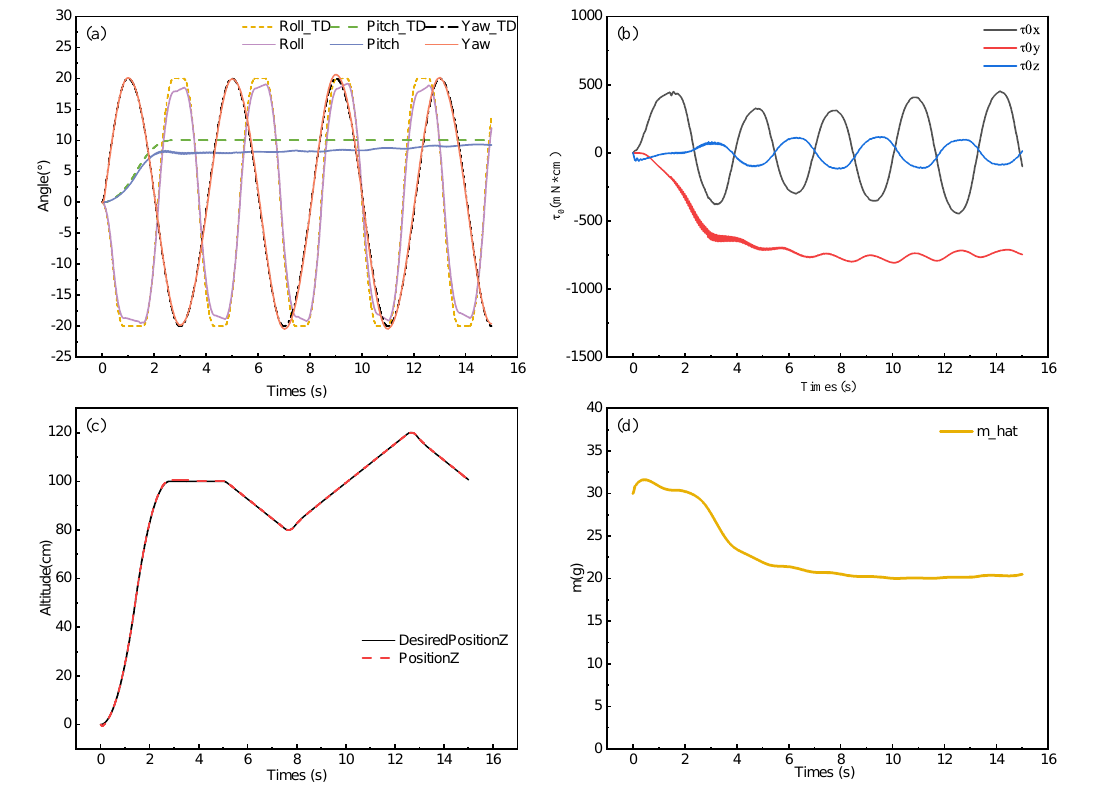
Figure 8. Simulation results of the adaptive attitude and altitude controller. The dashed lines are the control references. ( a ) Simulation results of attitude control. ( b ) The adaptation of bias torque. ( c ) Simulation results of altitude control. ( d ) The adaptation of